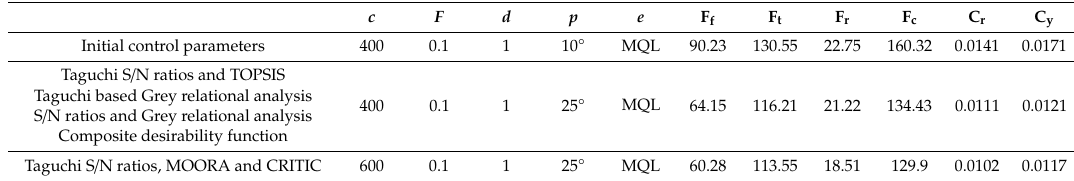
Table 12. Confirmation